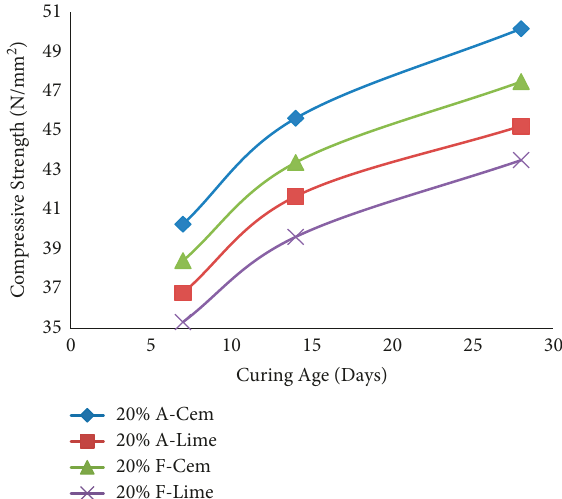
Figure 4: Compressive strength of cement and lime with 20% bagasse ash and fibre.